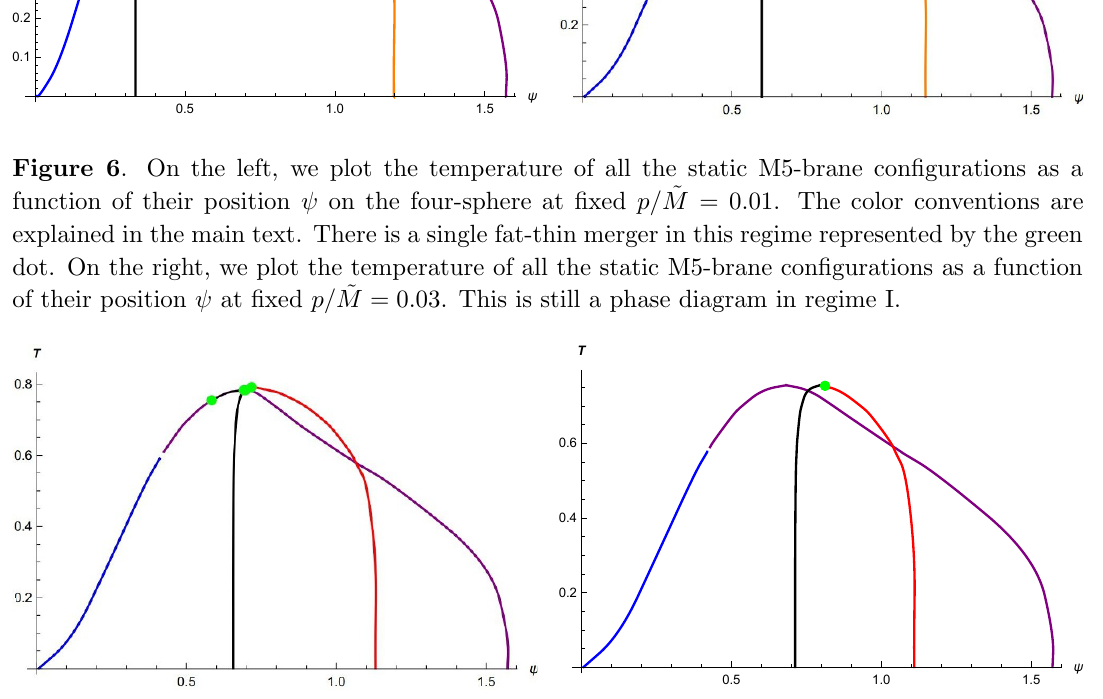
Figure 7 . On the left, we plot the temperature of all the static M5-brane con(cid:12)gurations as a function of their position at (cid:12)xed p= ~ M = 0 : 035. This is a representative phase diagram in regime II. There are three merger points in this diagram represented by green dots and two separate branches of metastable states represented by black segments. On the right, we plot the temperature of all the static M5-brane con(cid:12)gurations as a function of their position at (cid:12)xed p= ~ M = 0 : 04. This is a representative phase diagram in regime